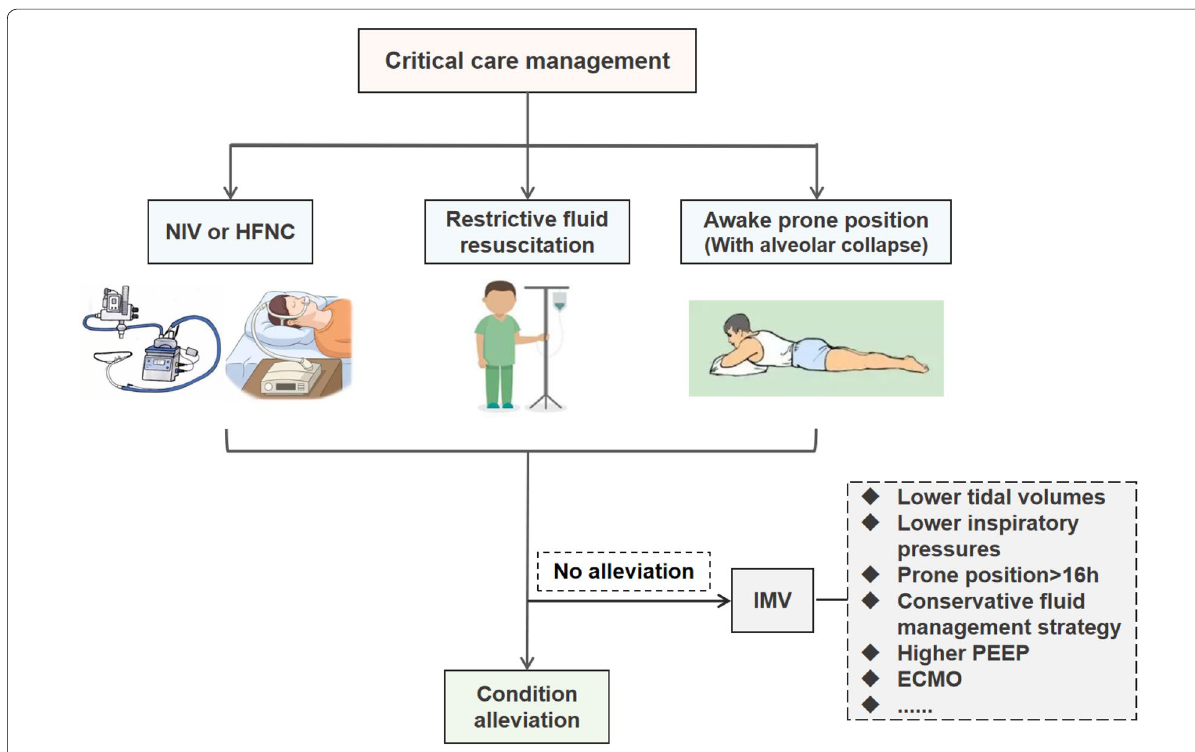
Fig. 2 Early intervention for patients with critical condition